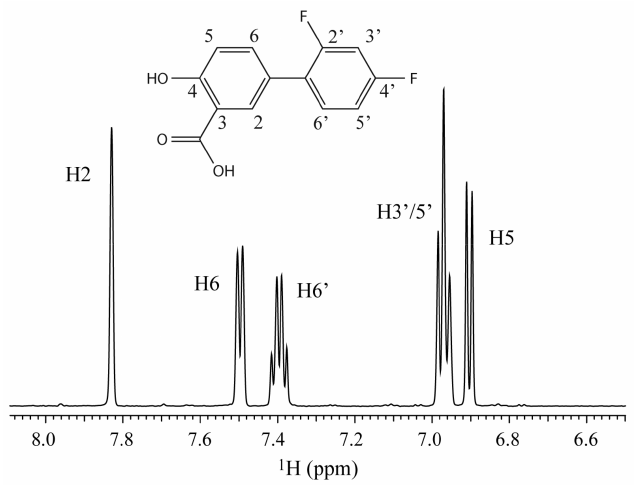
Figure 1. Structure and 1 H NMR spectrum of